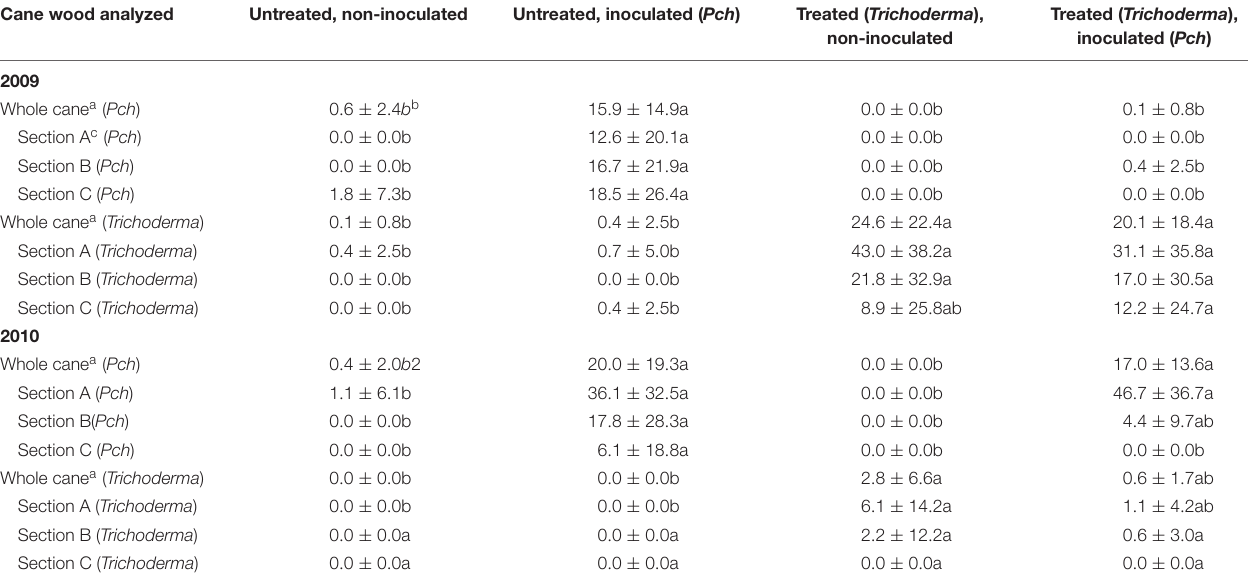
TABLE 4 | Colonization of canes by Phaeomoniella chlamydospora ( Pch ) and Trichoderma species following preventive treatment by the Trichoderma formulation and/or artificial inoculation with Pch